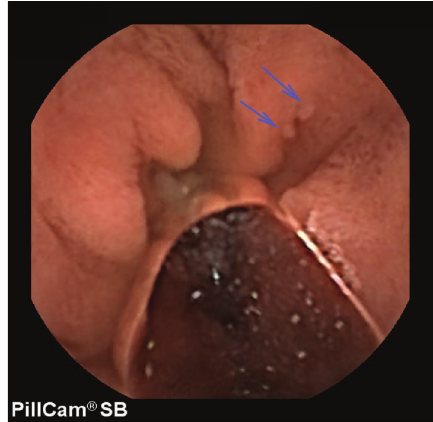
Figure 3: Capsule endoscopy revealed minimal polyps of normal color in the